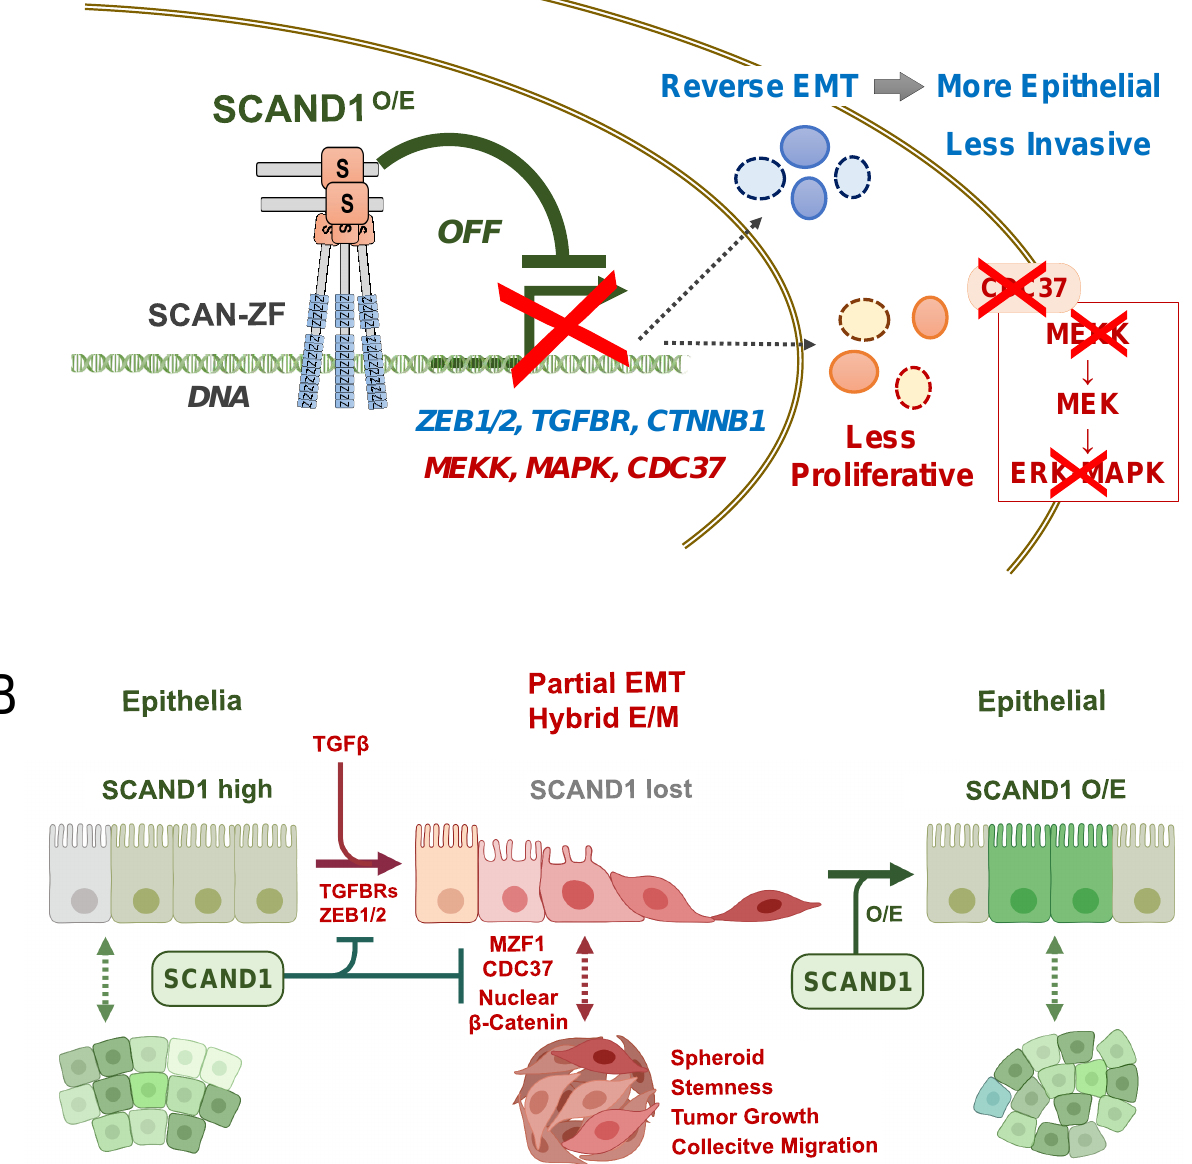
Figure 7. SCAND1 reverses hybrid E/M tumor cells to a more epithelial, less invasive status and inhibits their proliferation, migration, and metastasis. ( A ) Transcriptional repression by SCAND1 over- expression (O/E). The combination of SCAND1 and SCAN-ZF, such as MZF1, can repress EMT driver genes, including ZEB1/2, TGFBRs, and CTNNB1, to reverse EMT for establishing a more epithelial and less invasive phenotype. SCAND1 can also repress genes encoding kinases in MEKK- MEK-ERK/MAPK signaling pathway to inhibit tumor cell proliferation. ( B ) Partial EMT (or hybrid E/M) is controlled by SCAND1. SCAND1 maintains the epithelial status of cells, whereas the loss of SCAND1 may initiate EMT. SCAND1 O/E can reverse EMT to retrieve epithelial